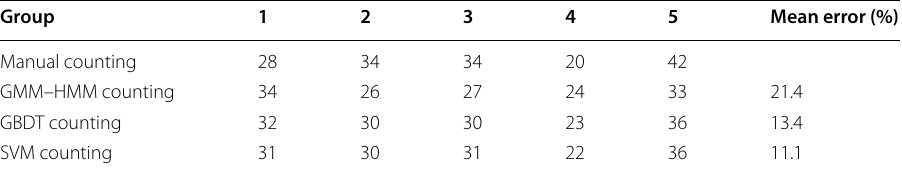
Table 2 Comparison of dynamic monitoring results with dense personnel density Group